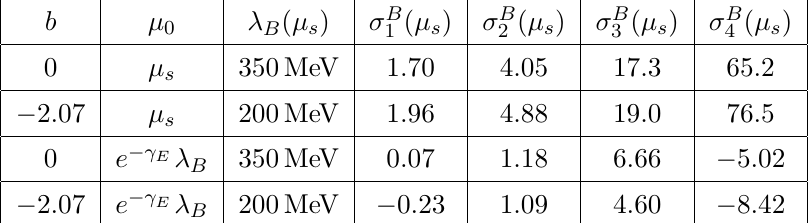
Table 2 . Model parameters (left) and logarithmic moments (right) of the model functions defined in two different schemes, where the parameter ¯ ω in (1.5) is replaced by µ 0